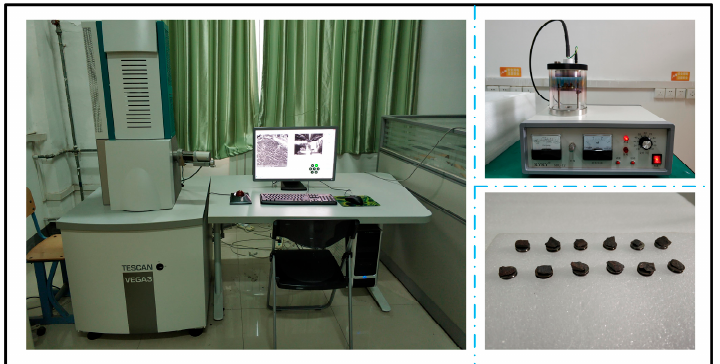
Figure 12. TESCAN VEGA3 scanning electron microscopy (SEM) test system.